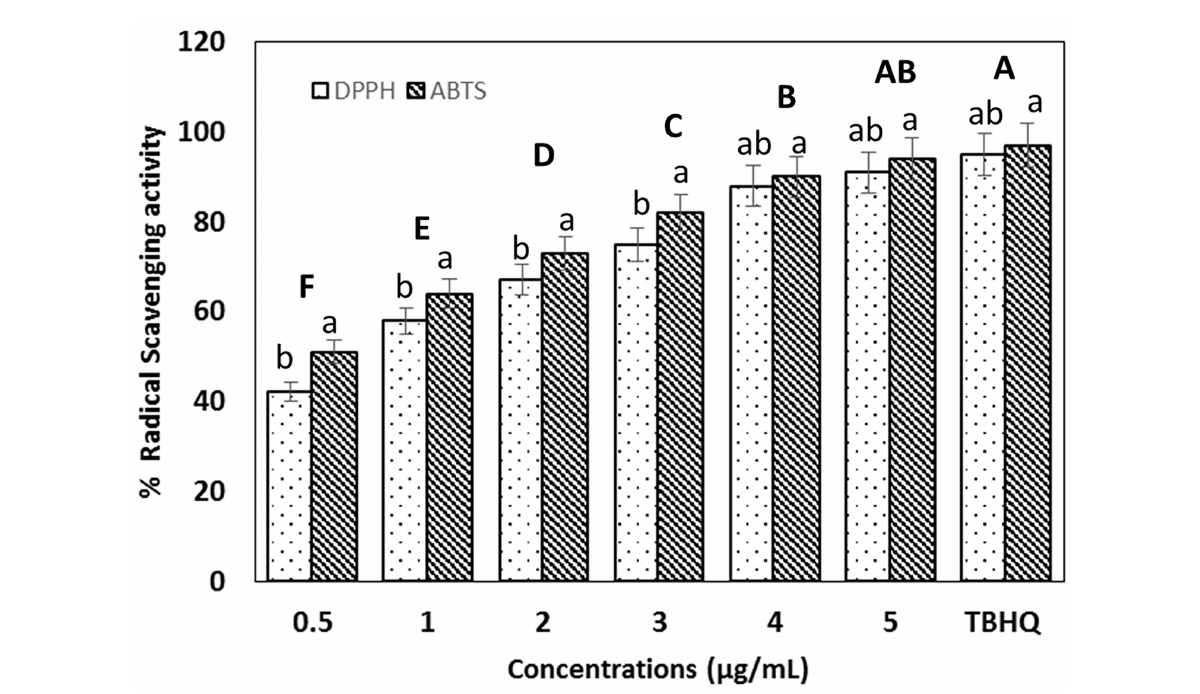
FIGURE 4 Radical scavenging activity of biosynthesized selenium nanoparticles (BioSeNPs) at different concentrations (0.5–5 μ g ml − 1 ) against ABTS and DPPH radicals after 30 min. of incubation, as compared to tret-butyl hydroquinone (TBHQ 5 μ g ml − 1 ). Data are presented as means ± SE. Bold uppercase letters indicate the significant differences between concentrations as compared to TBHQ, while lowercase letters indicate significant differences between DPPH and ABTS subjected to SeNPs and